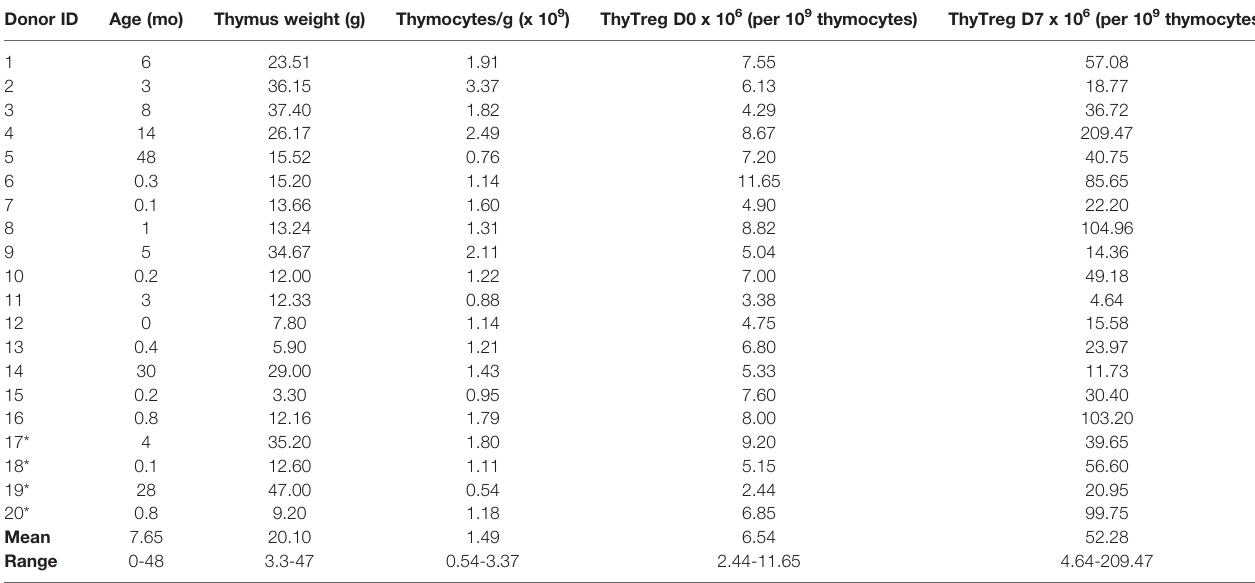
TABLE 1 | Characteristics of processed thymuses and thyTreg